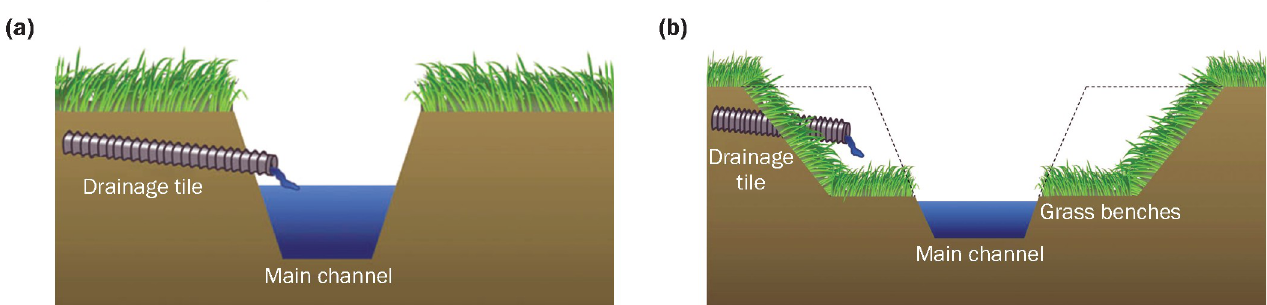
Fig 1. Schematic comparing (a) conventional trapezoidal ditch design and (b) two-stage ditch design [23].